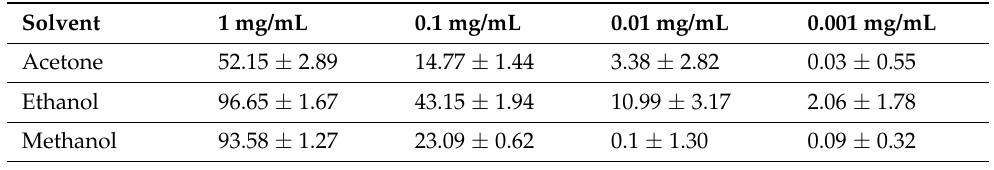
Table 3. Inhibitory effect of Coronopus didymus extracts (mean ± standard deviation) against alpha glucosidase.